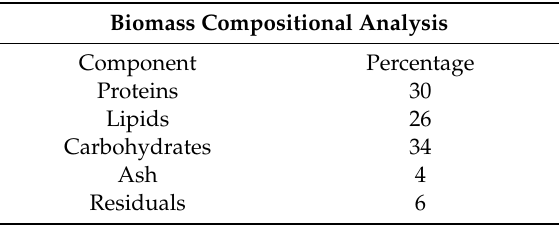
Table 1. Biomass composition of Synechococcus cultivated in F / 2 medium.